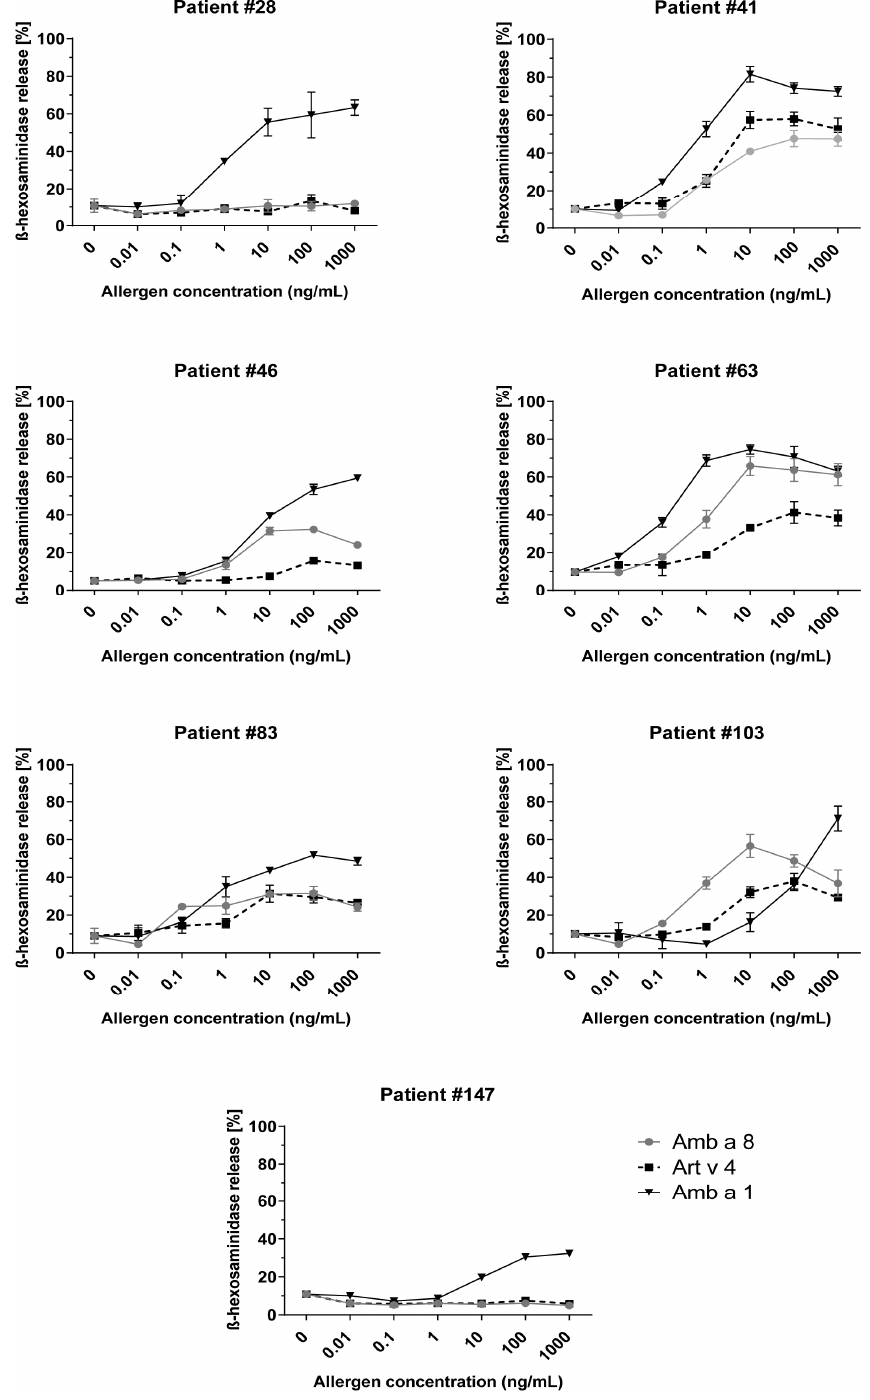
Figure 3. Allergenic activity of ragweed and mugwort profilins. RBL cells were loaded with sera of seven patients and stimulated with different concentrations of rAmb a 8 and rArt v 4; x-axes. β -hexosaminidase releases are expressed as percentages of total mediator contents +/ − SD (y-axes). The allergenic activity of nAmb a 1 was evaluated in all patients as a